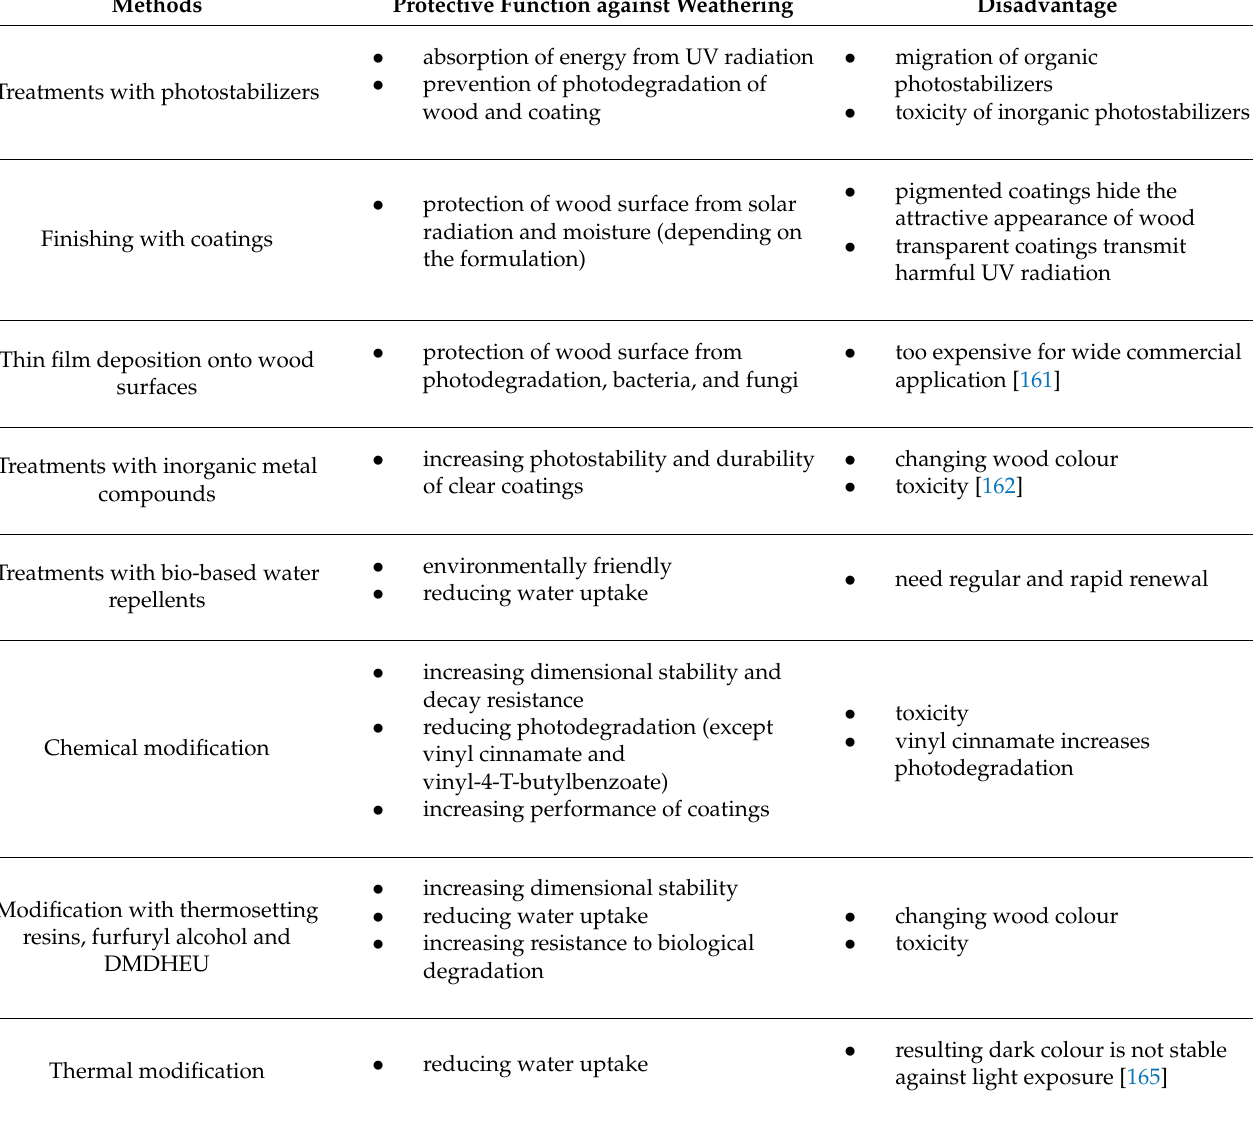
Table 2. Protective functions of method of surface protection against weathering and their disadvantages.